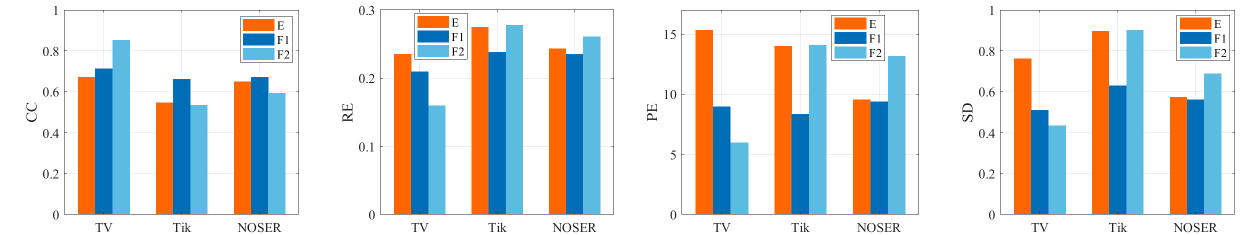
Figure 11. Quantitative analysis of the experimental results.